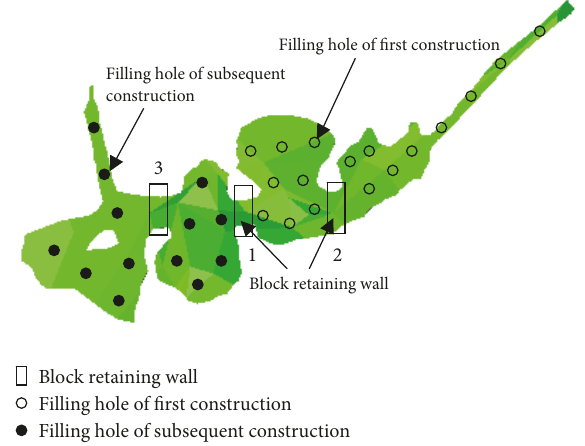
Figure 6: Treatment scheme for the mined-out area under the final slope of the open-pit